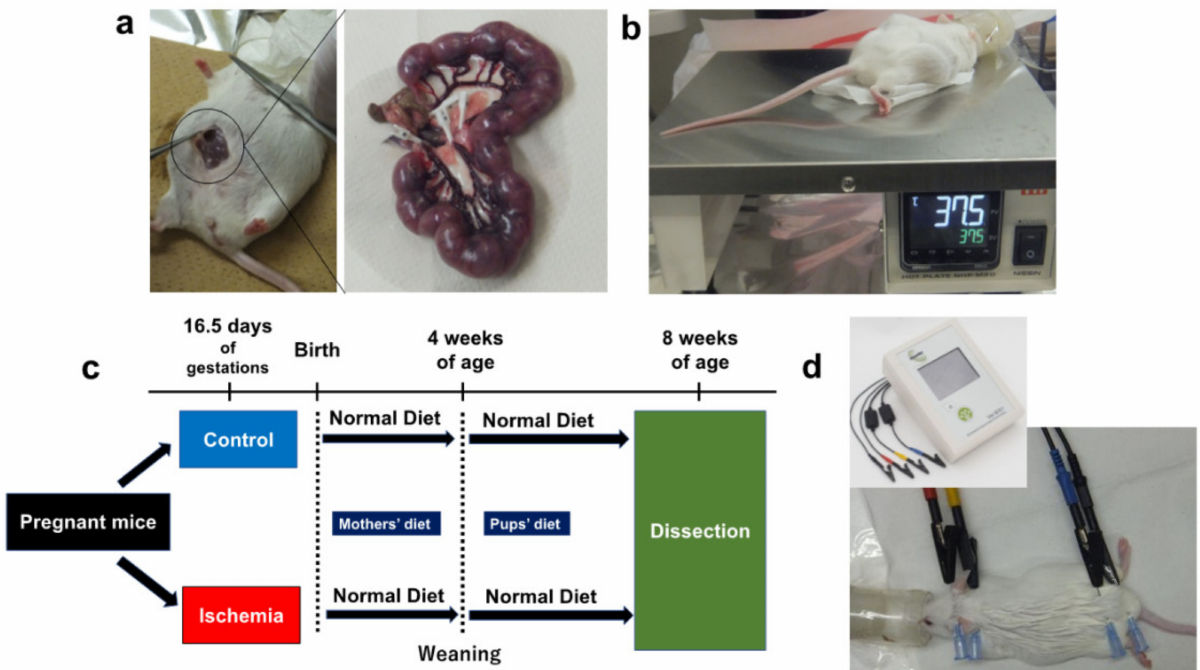
Figure 1. Experimental procedures . ( a ) Uterine artery ligation in pregnant mice (ischemia for 15 min). ( b ) Body temperature control on a hot plate (37.5 ◦ C). ( c ) Study flow of this study. ( d ) Body composition measurements using ImpediVET TM (Bioresearch center, Co., Ltd., Nagoya,